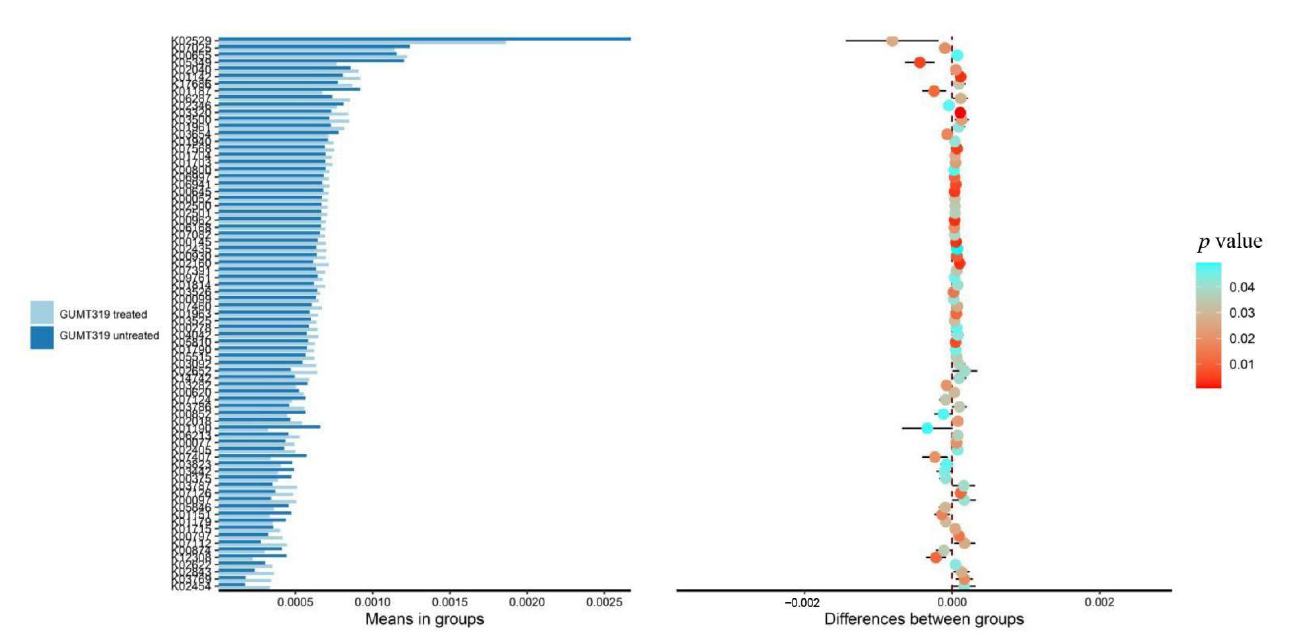
Figure 6. Differences and changes related to functional genes in the microbial community of GUMT319-treated and untreated samples in the metabolic pathway.